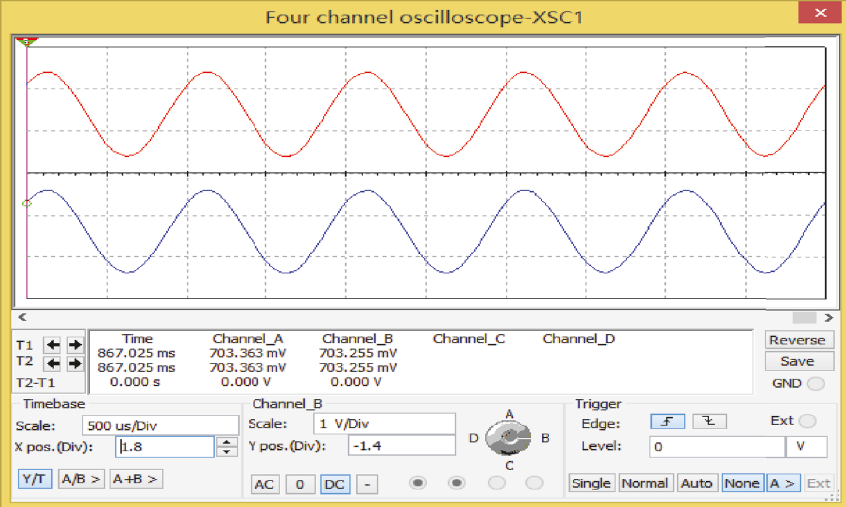
Figure 16: Transmitting and receiving waveforms with amplitude of 1V and frequency of